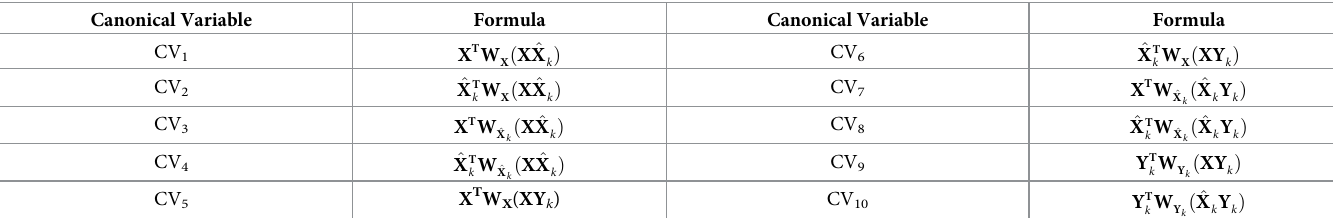
Table 1. Mathematical description of the 10 CVs depicted in Fig 2. Canonical Variable Formula Canonical